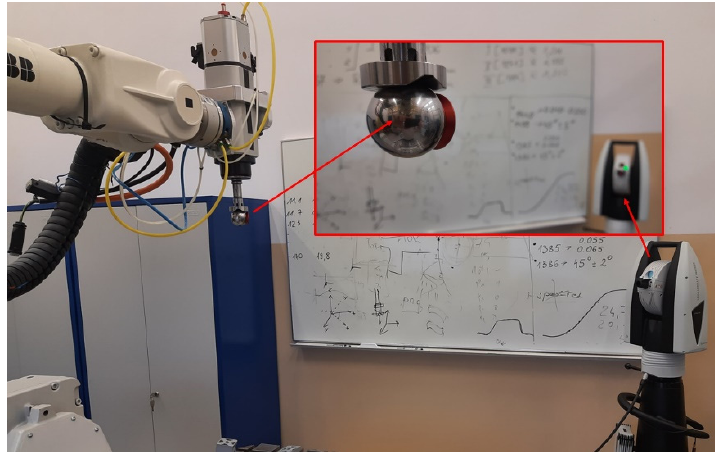
Figure 16. Retroreflector in the tool holder and the laser tracker.